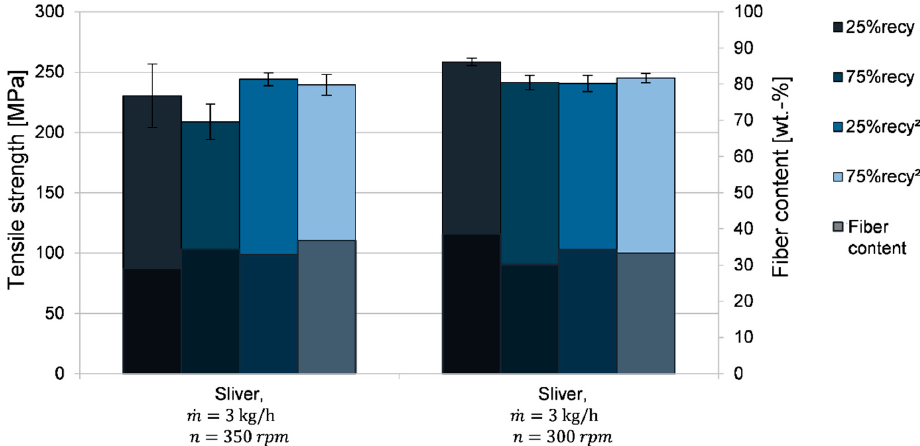
Figure 14. Young’s moduli of specimens produced in the single-stage process with varying recycling content and corresponding fiber content of the matrix.